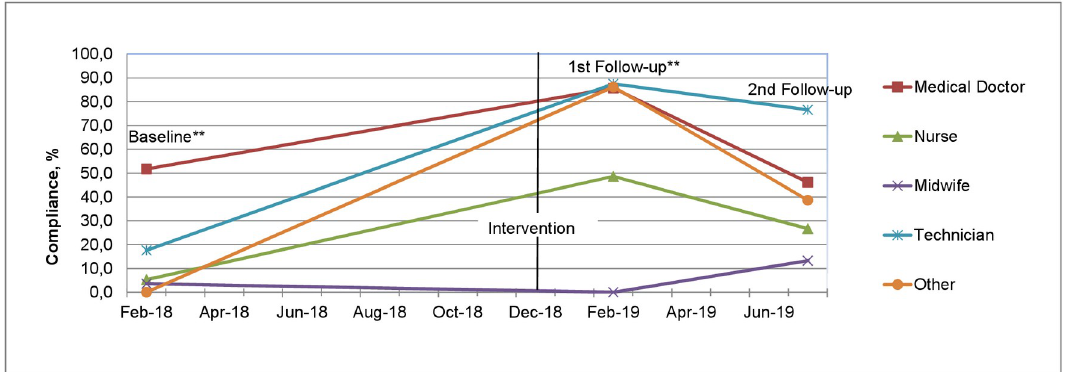
Fig 2. Hand hygiene compliance at baseline, 1 st and 2 nd follow-up, by profession. �� Baseline and 1 st follow-up data from previous publication [13].